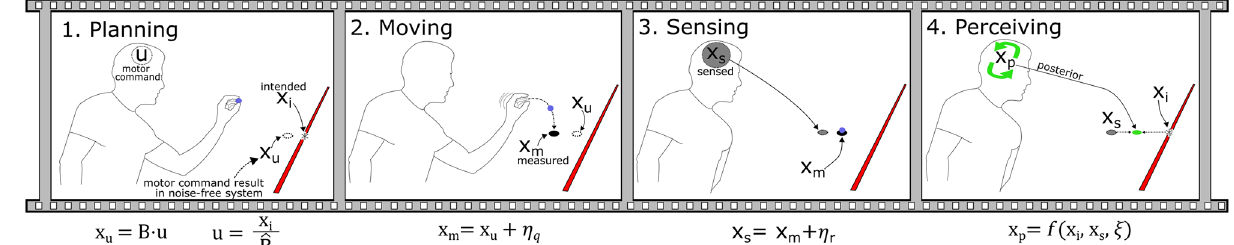
Figure 2. Overview of the movement generation framework during a task of tossing a ball to hit a target. In the Planning phase, the thrower generates a motor command ( u ) that, in a noise-free environment, will result in a specific ball landing point ( x u ) . In other words, a control action u is formed using an inverse model of the user’s estimate of system dynamics